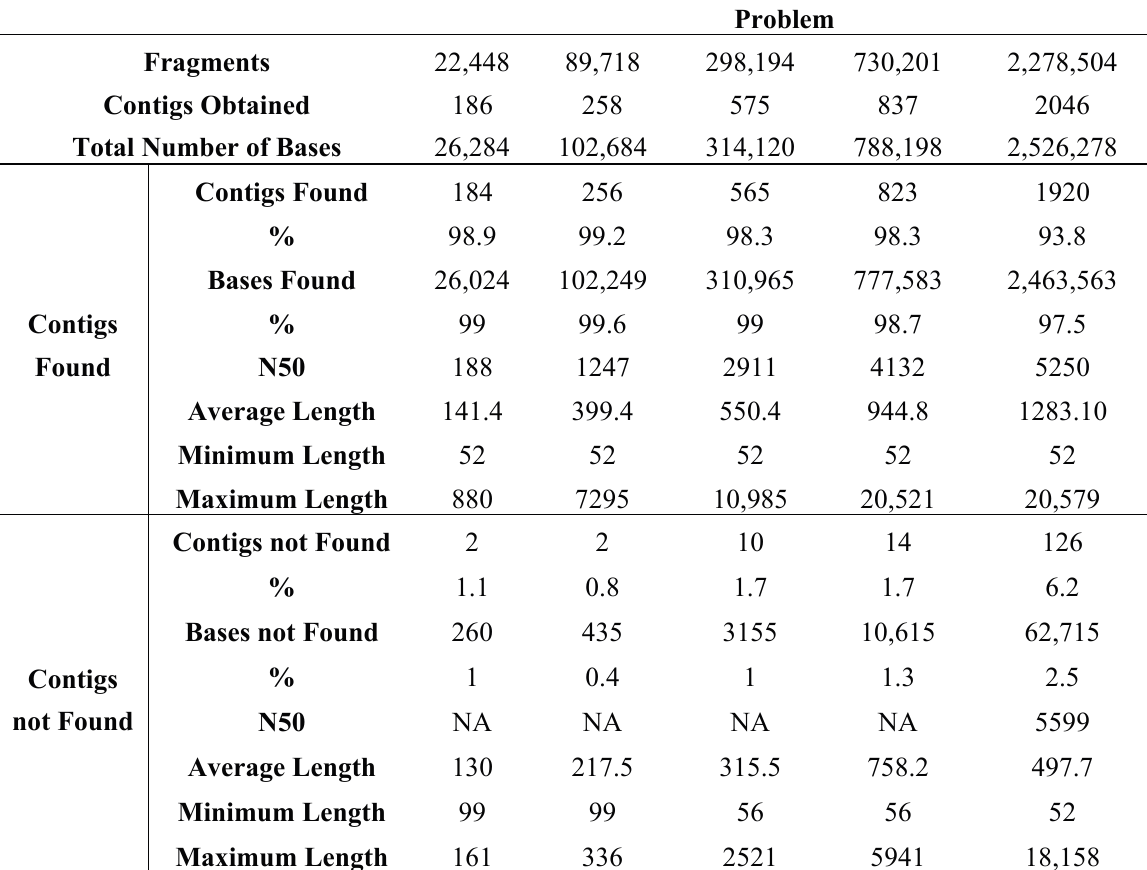
Table 4. Edena benchmark